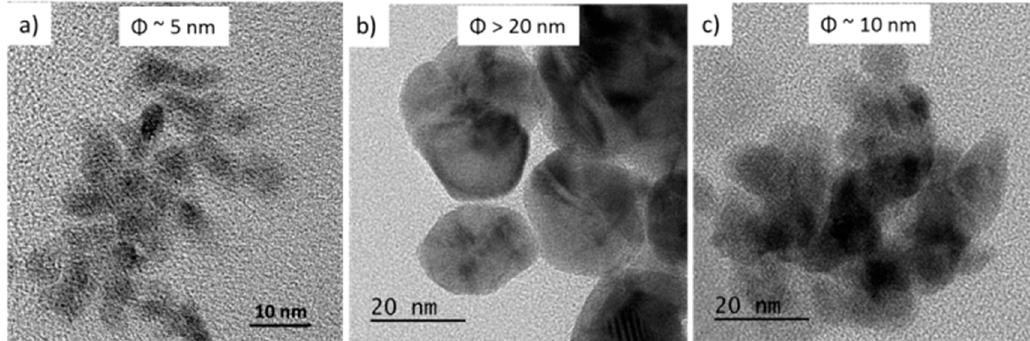
Figure 2. TEM images of Pd@OS NPs: ( a ) Pd@[BnNMe 3 ][Br]; ( b ) Pd@[C 16 NMe 3 ][Br] and ( c ) Pd@[C 16 NMe 3 ][NTf 2 ].